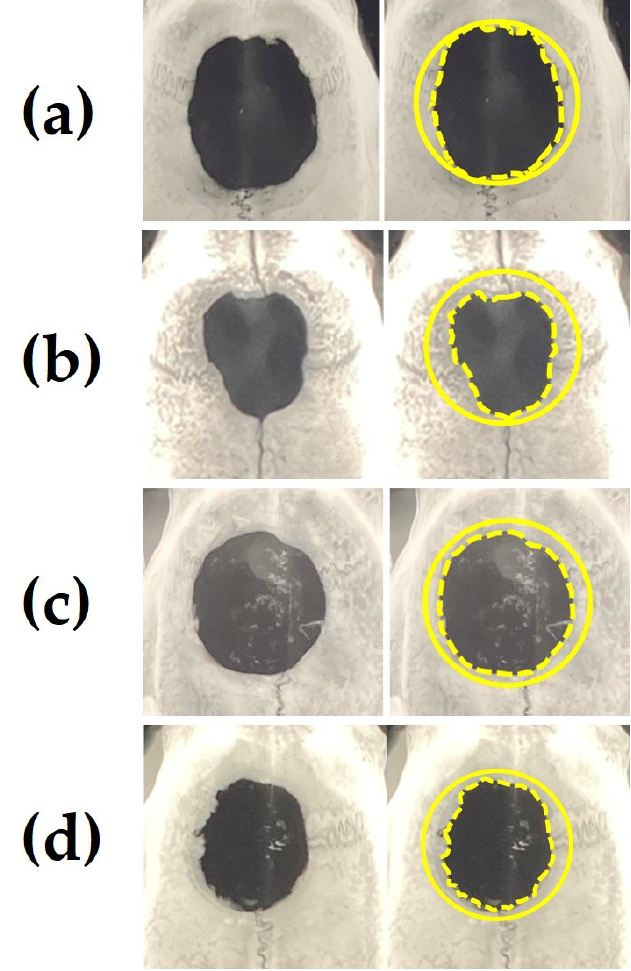
Figure 9. Representative soft X-ray images of a rat cranial bone defect with and without three AG-infiltrated and b-FGF-loaded granules, including ( a ) defect without granules and defects with ( b ) Col control + AG + b-FGF, ( c ) AI 20 min 5Cy Col/Hap + AG + b-FGF, and ( d ) AI 60 min 5Cy Col/Hap +AG + b-FGF. Note: left, raw data; right, the original defect and edges of extending bones are depicted by solid circles and broken lines, respectively.